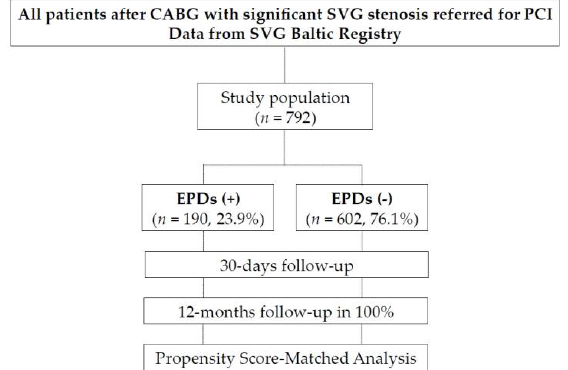
Figure 1. Study flow chart in the SVG PCI PROTECTA Study. CABG—coronary artery bypass graft, SVG—saphenous vein graft, PCI—percutaneous coronary intervention, EPDs—embolic protection devices.